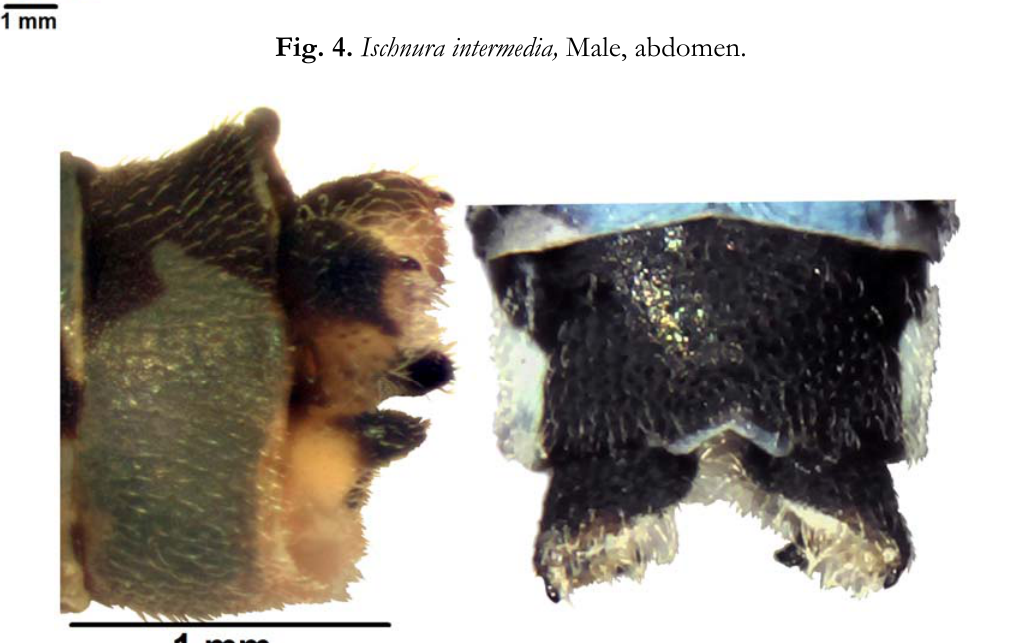
F IGURE 5. Ischnura intermedia, Male, appendages from lateral (a) and dorsal view